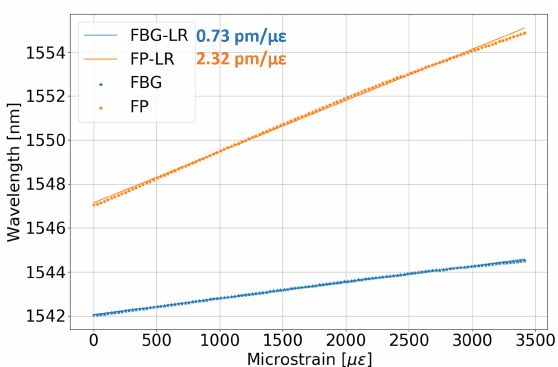
Figure 11. Peak wavelength response of the FP and